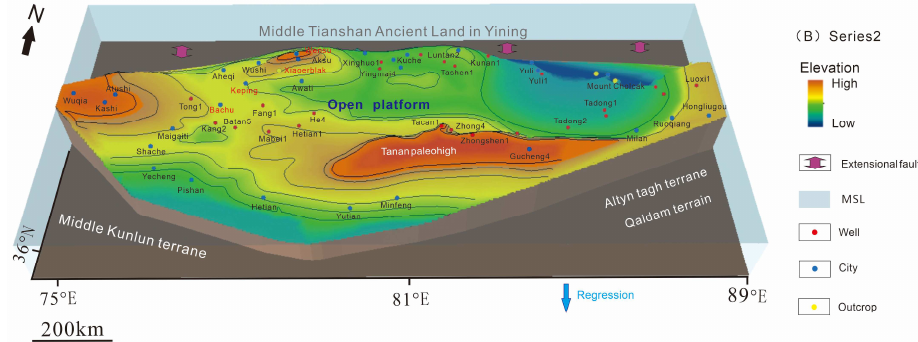
Figure 4. Sedimentary paleogeomorphic characteristics of Cambrian Series2 in the Tarim Basin.